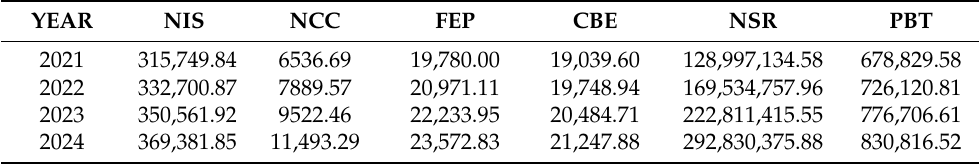
Table 18. Results of